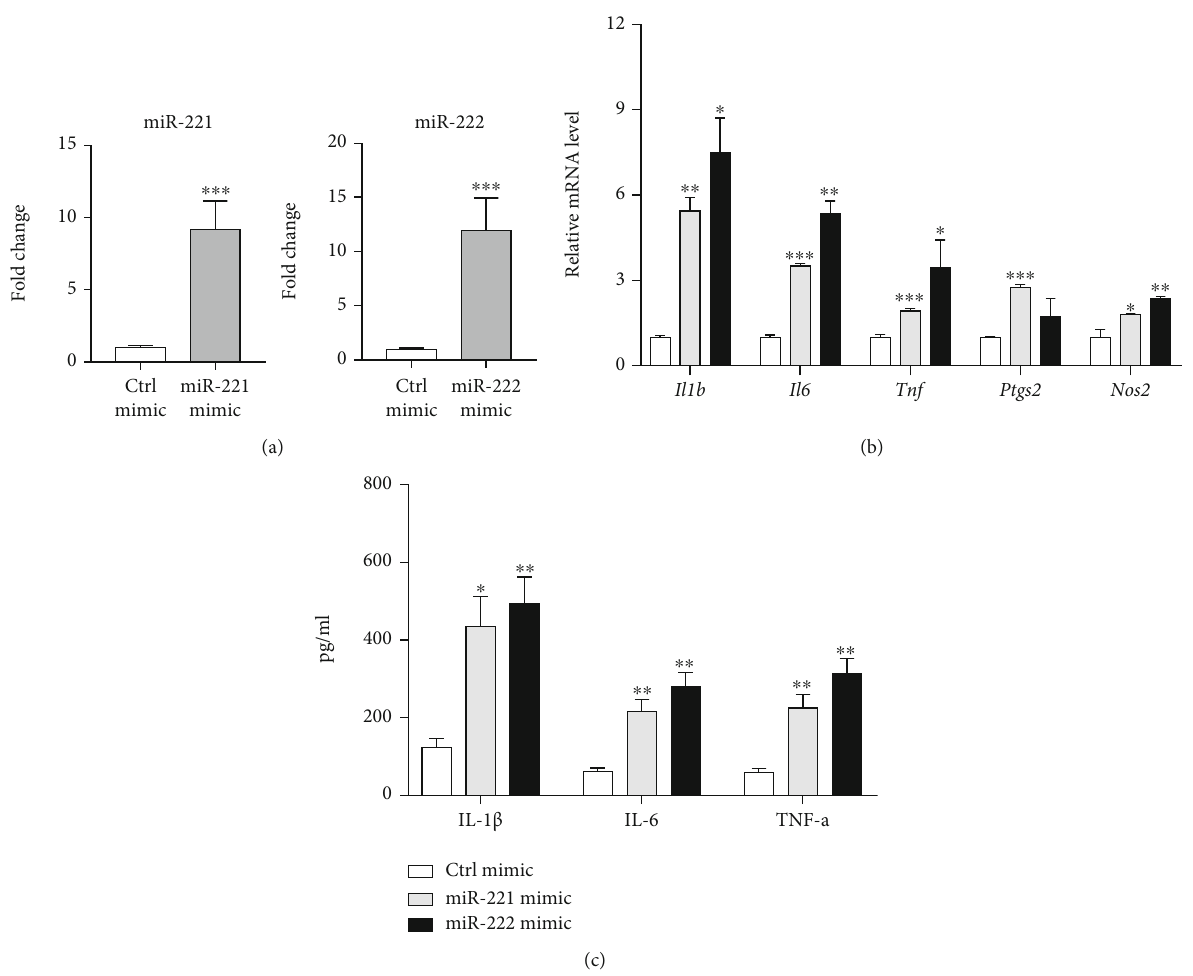
Figure 2: E ff ect of miR-221/222 on activation of BV2 microglia. (a) The transfection e ffi ciency of miR-221 and miR-222 mimics was validated by qRT-PCR analysis. (b) The e ff ects of miR-221 and miR-222 mimics on the mRNA expression of in fl ammatory genes ( Il1b , IL6 , Tnf , Ptgs2 , and Nos2 ) in BV2 cells were determined by real-time qPCR analysis ( n = 3 ). (c) The levels of in fl ammatory cytokines (IL-1 β , IL-6, and TNF-